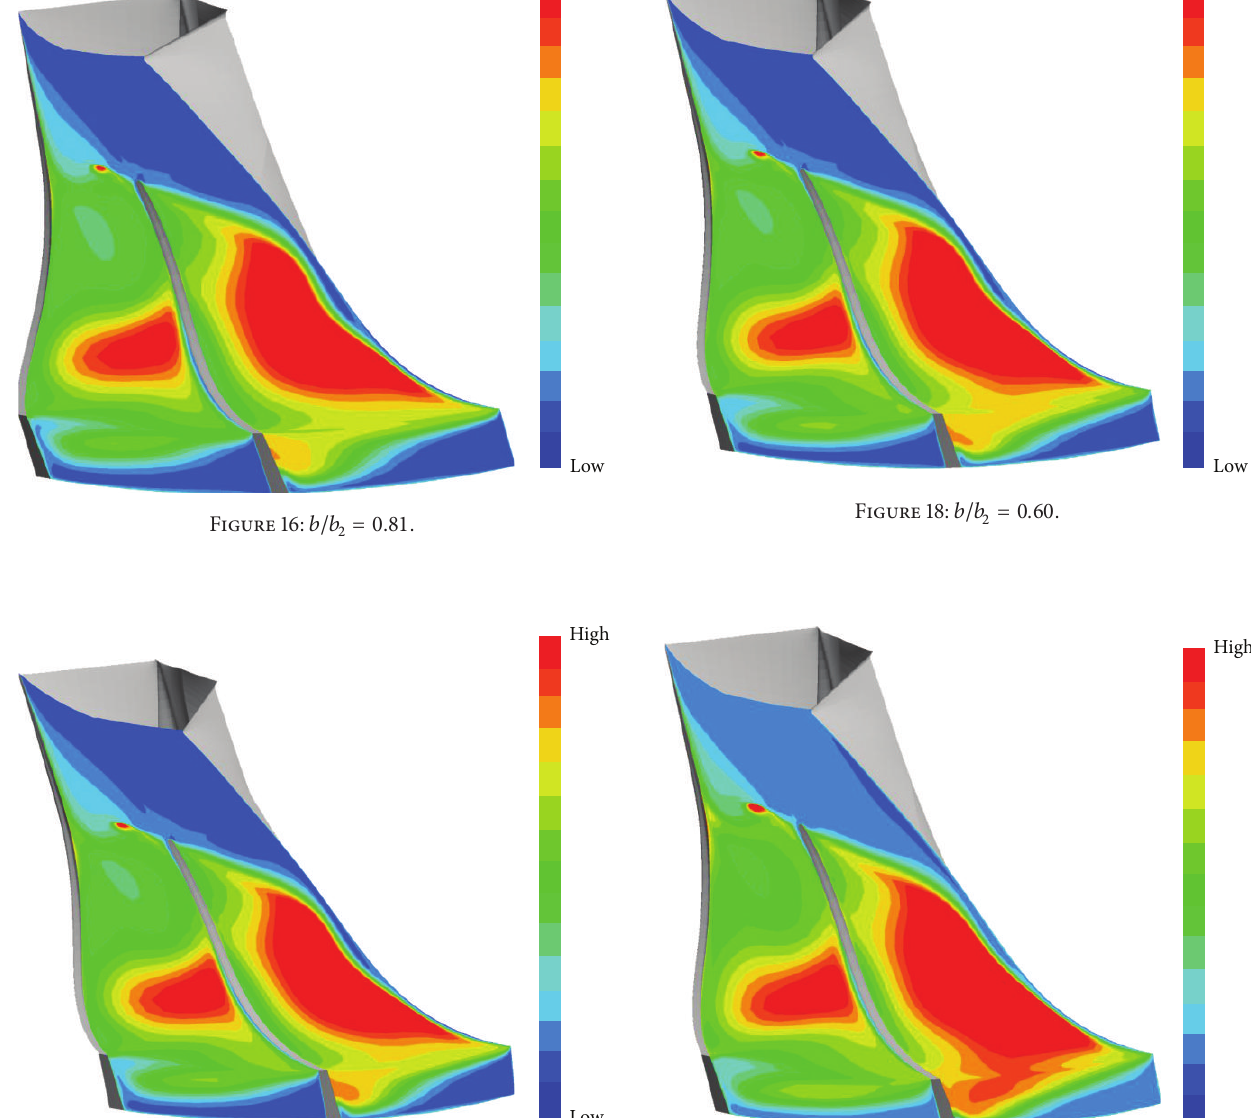
Figure 17: 𝑏/𝑏 2 = 0.75 .